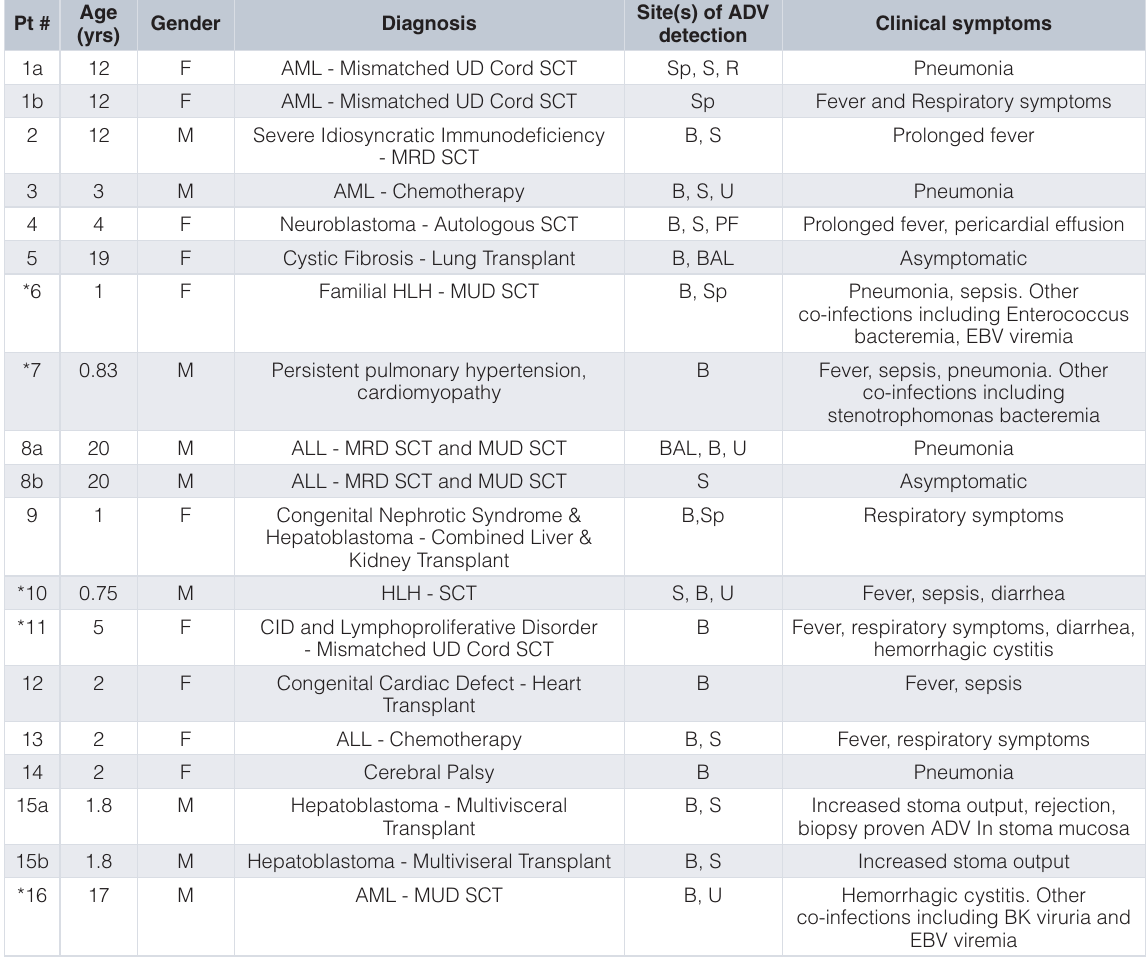
Table 1. Demographics, primary diagnosis, sites of ADV detection, clinical symptoms and course of patients included in the study. The age and gender distribution, primary diagnosis, sites of adenovirus detection, symptoms and clinical course of the patients included in the study are